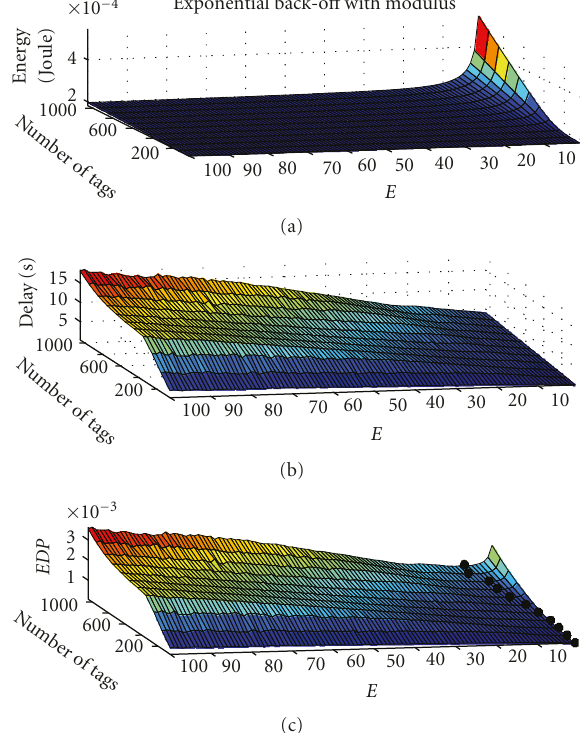
Figure 13: Exponential back-o ff algorithm with modulus.